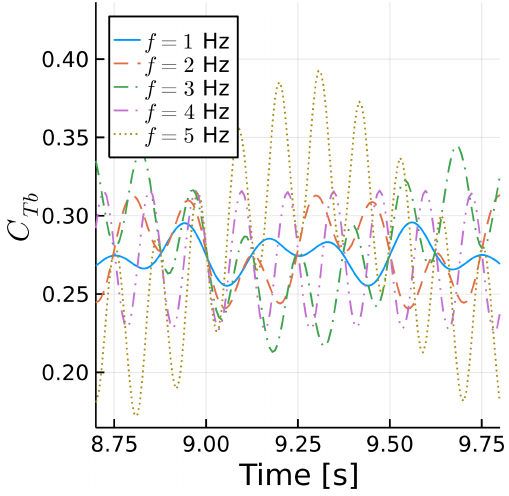
Figure 19. Time history of blade 1 thrust coefficient for various yaw frequencies.